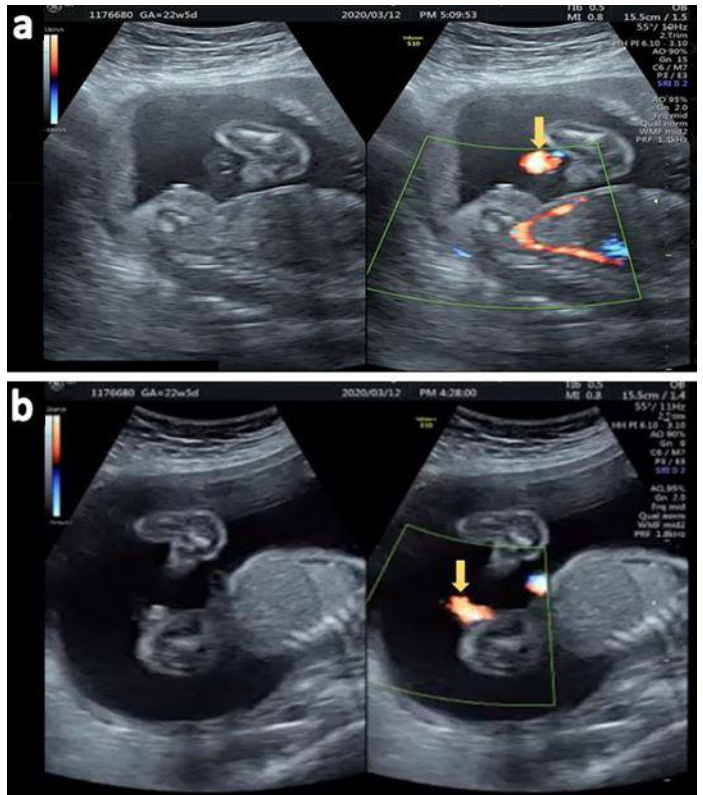
Figure 6. ( a ) Fanning of the urinary stream jet proximal to the perineum (arrow) ( b ) Sagittal view of the ventral jet of urinary stream under color Doppler (arrow)